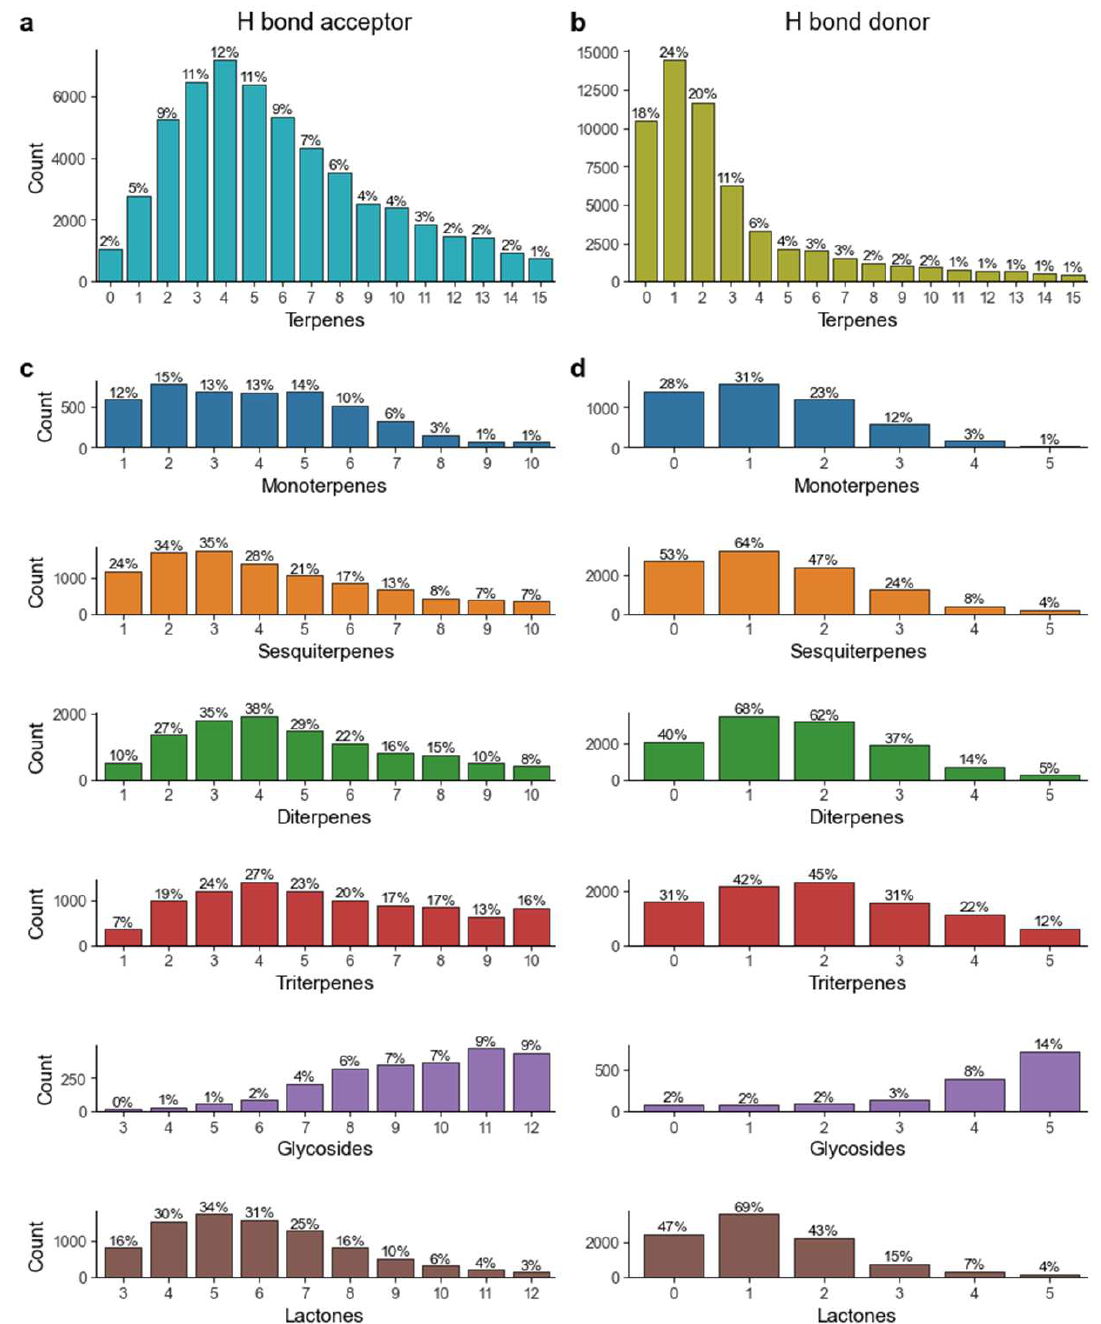
Figure 6. Number of hydrogen bond ( a ) acceptors and ( b ) donors in the terpene chemical space and on a subclass basis for ( c ) acceptors and ( d ) donors.